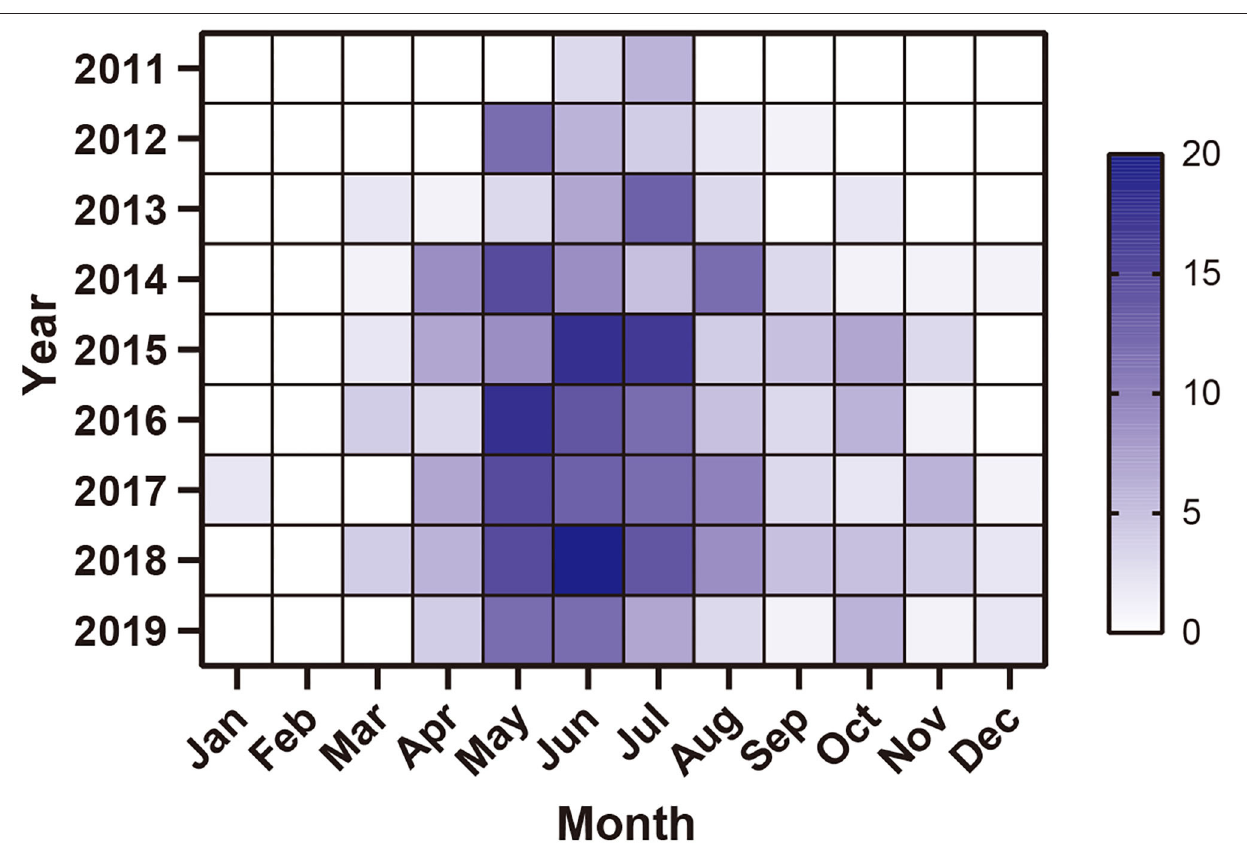
FIGURE 6 | Monthly distribution of SFTS cases in Zhejiang Province from 2011 to